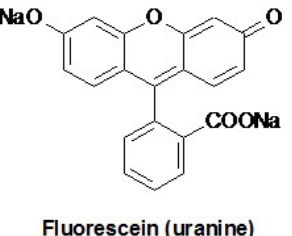
Figure 1: Sodium